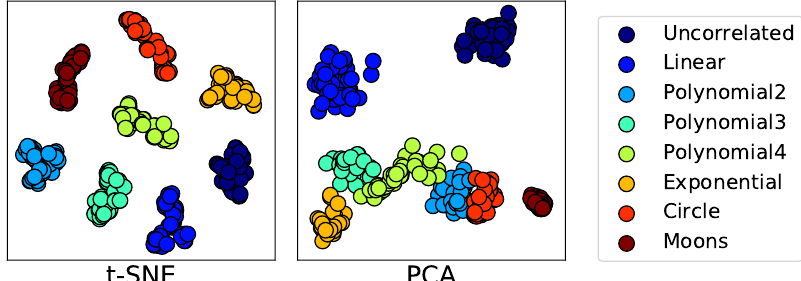
Figure 5. Visualizations of dependence representations learned with dependence type